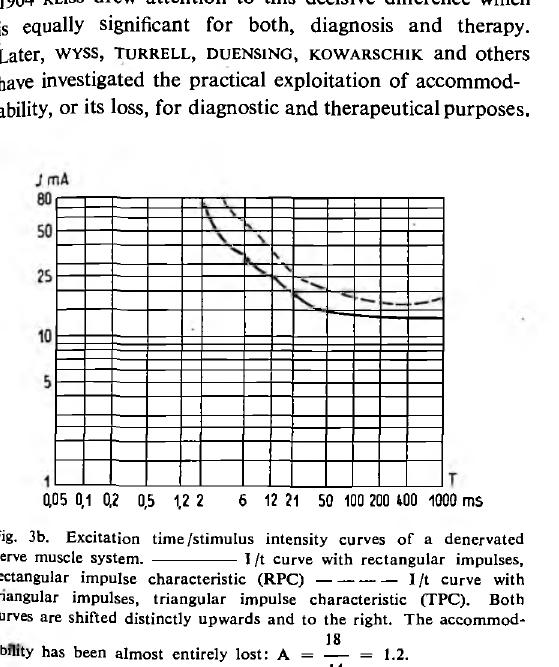
Fig. 3b. Excitation time /stimulus intensity curves of a denervated nerve muscle system. --------------- 1 /t curve with rectangular impulses, Rectangular impulse characteristic (R PC )---------------I/t curve with CTiangular impulses, triangular impulse characteristic (TPC). Both ^curves are shifted distinctly upwards and to the right. The accommod- 18 ability has been almost entirely lost: A = ---- = 1.2.